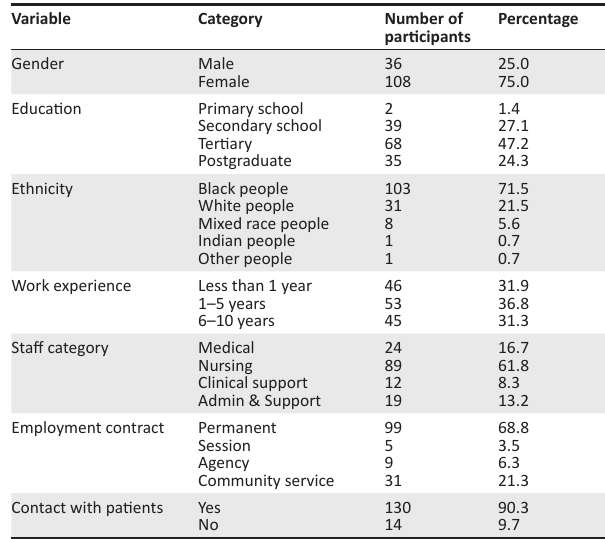
TABLE 2: Demographic profile of